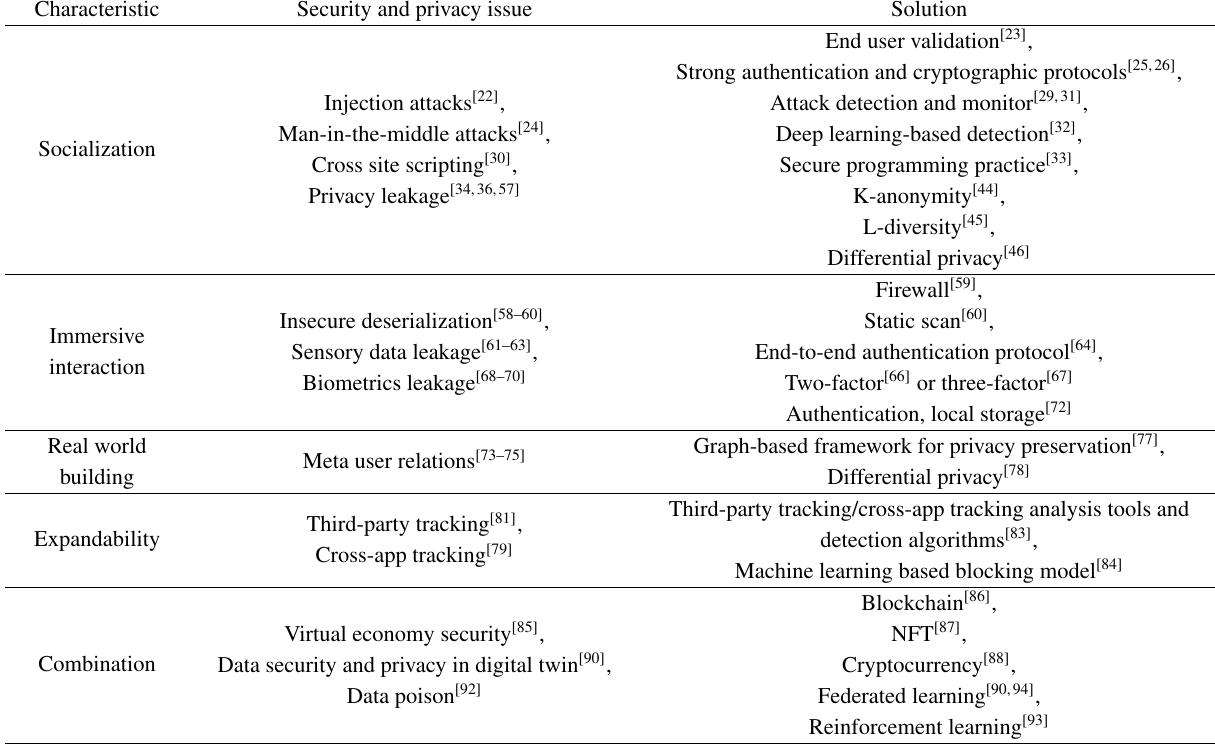
Table 1 Metaverse applications, security and privacy issues and solutions